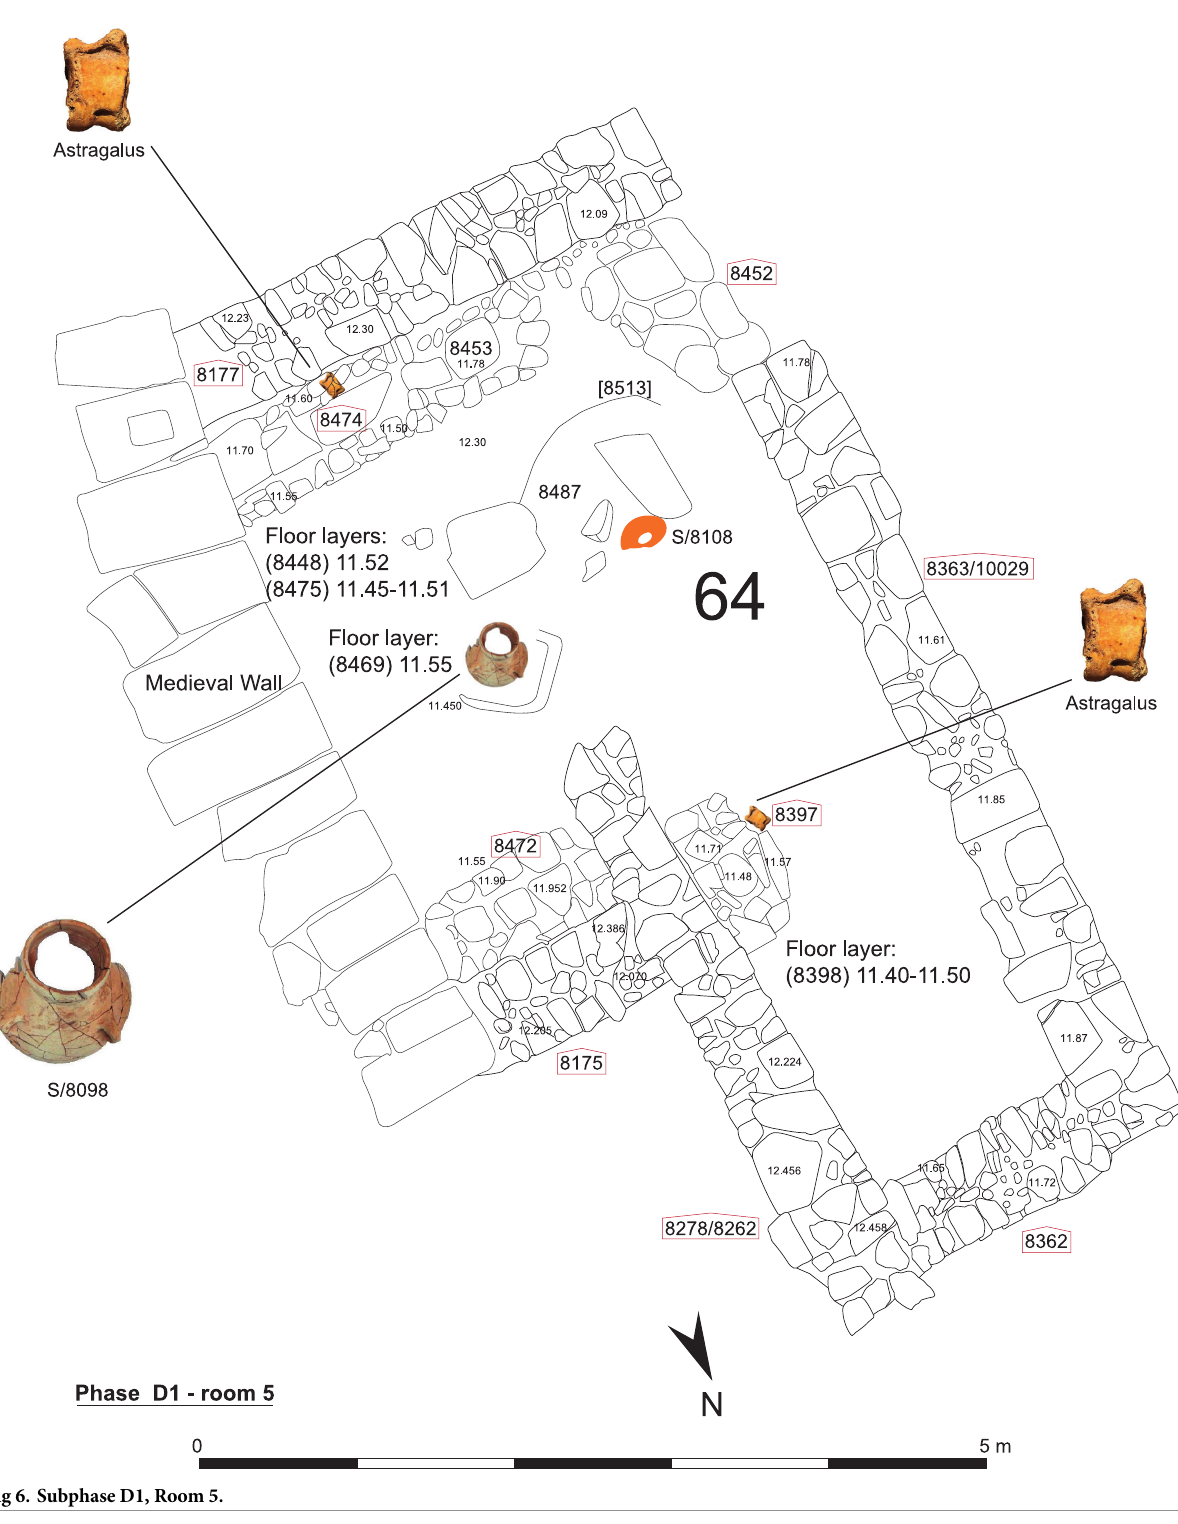
Fig 6. Subphase D1, Room